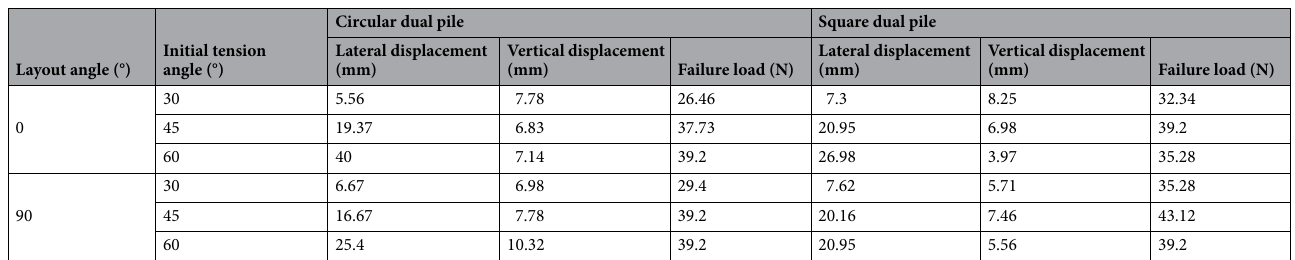
Table 4. Maximum displacement of pile top under variables